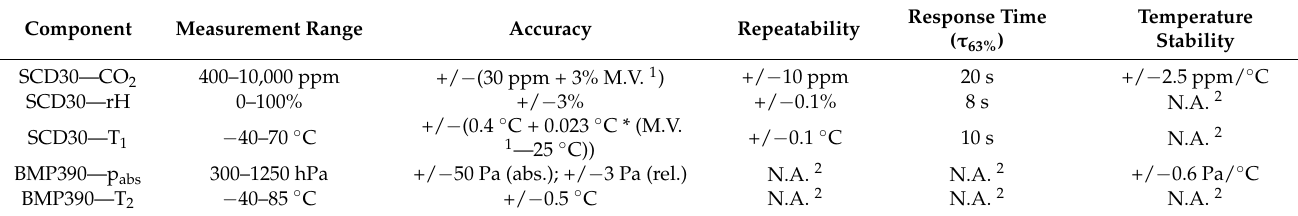
Table 1. Sensor Table 1. Sensor specifications.